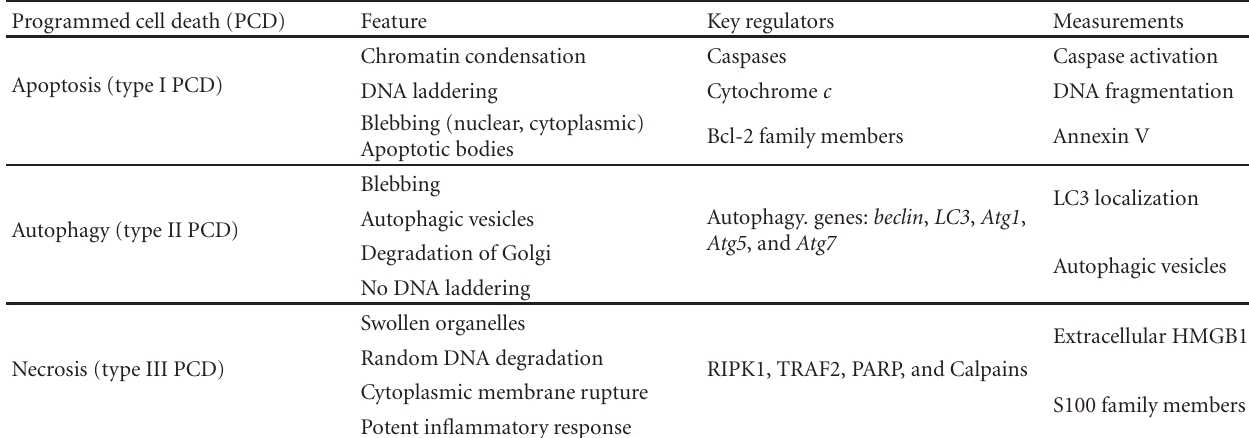
Table 2: Characteristic features of programmed cell death.